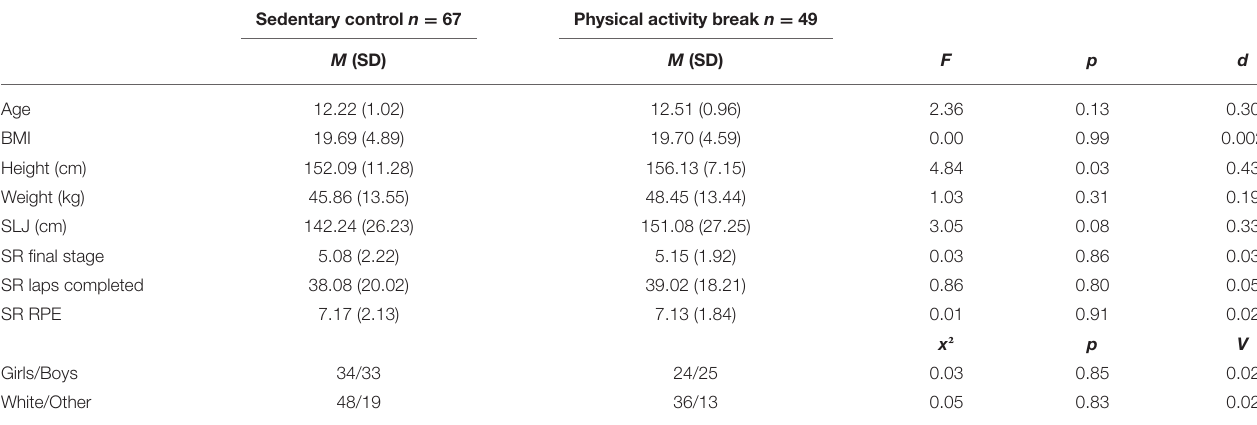
TABLE 1 | Demographic, anthropometric, and physical fitness scores by group. Sedentary control n = 67